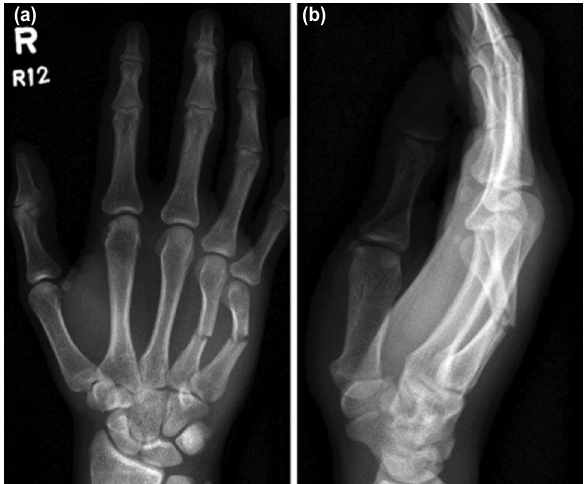
Post-operative radiographs (a) PA and (b) Lateral views Fig. 4: of united transverse mid metacarpal ring and little finger shaft fractures with the locked intramedullary nail in-